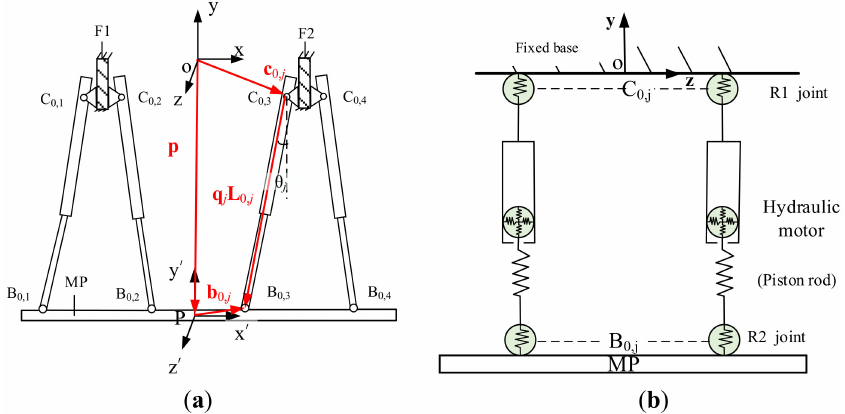
Figure 7. Kinematic models of 4-(2RPR) parallel planar mechanism. ( a ) Kinematic model of the 4-(2RPR) redundant parallel manipulator; ( b ) topology structure of 4-(2RPR) kinematic